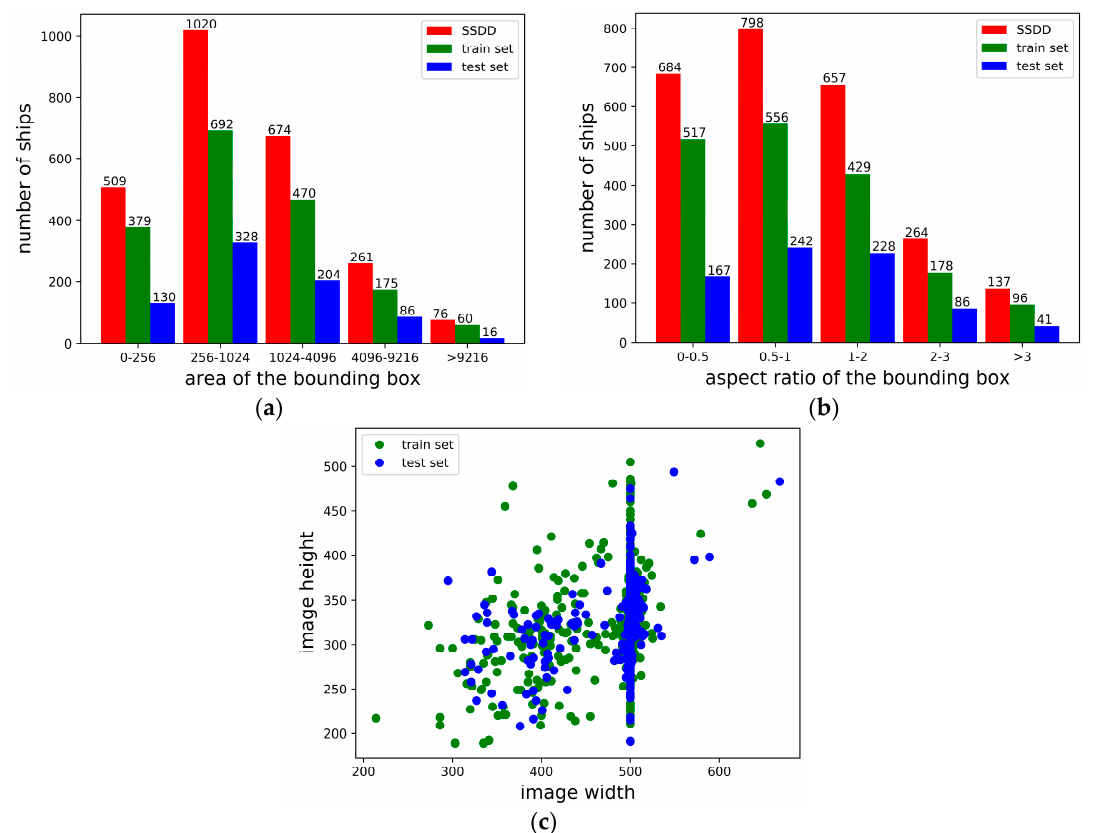
Figure 8. Statistical results of the SSDD. Statistical results of the training, testing, and the entire dataset are depicted as bars with di ff erent colors. ( a ) the number of ships with di ff erent areas of the bounding box; ( b ) the number of ships with a di ff erent aspect ratio of the bounding box; ( c ) the width and height of the image.